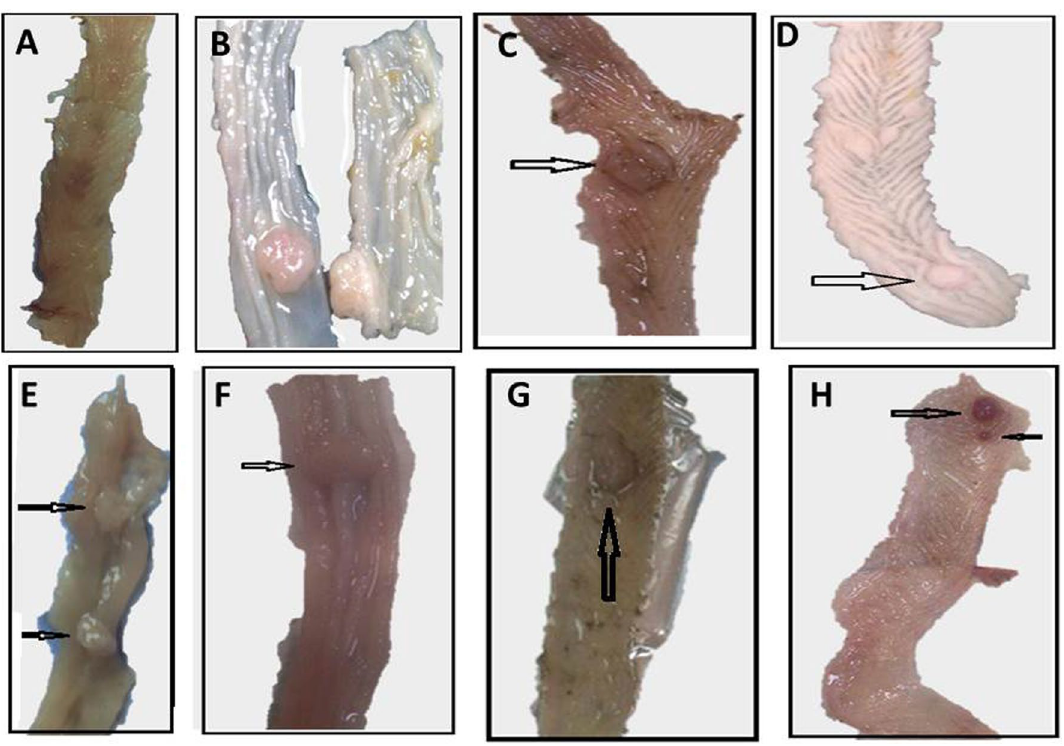
Fig. 3 Macroscopic examination of colorectal tissue from A Control, B DMH, C DMH + Cis, D , E DMH + T, F DMH + R, G DMH + Cis + R, H DMH + T + R groups, The arrows refer to polyps of colorectal cancer